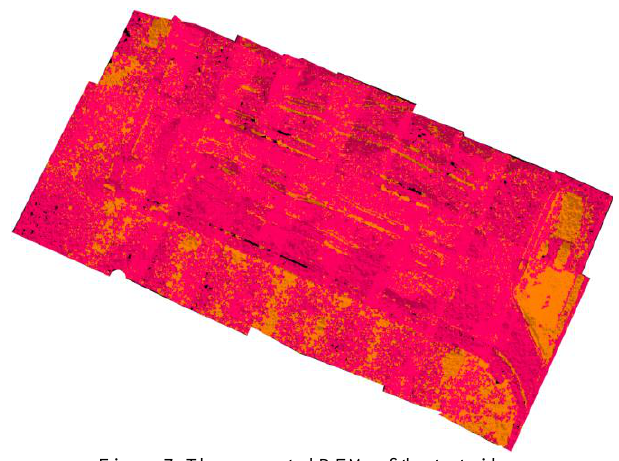
Figure 7. The generated DEM of the test side The ortho images were generated with Erdas LPS module with the ground sample distance of 2 cm using the all recorded image with UAV system. The mosaic image which covers all test side with the GSD of 2 cm was generated (Figure 8).